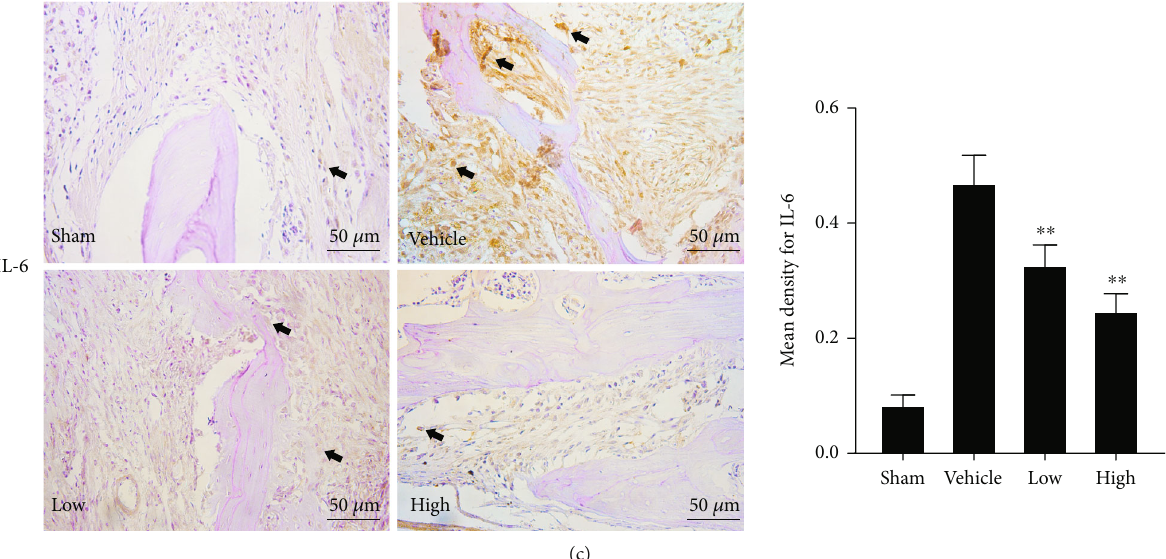
Figure 3: Tetrandrine (Tet) inhibits the expression of proin fl ammatory cytokines. (a) Immunohistochemical staining of tumor necrosis factor (TNF)- α . (b) Immunohistochemical staining of interleukin (IL)-1 β . (c) Immunohistochemical staining of IL-6. The mean density for TNF- α , IL-1 β , and IL-6 were quanti fi ed ( ∗ p < 0 : 05 , ∗∗ p < 0 : 01 compared with the vehicle group; n = 5 per group). Black arrows indicate positive expression,